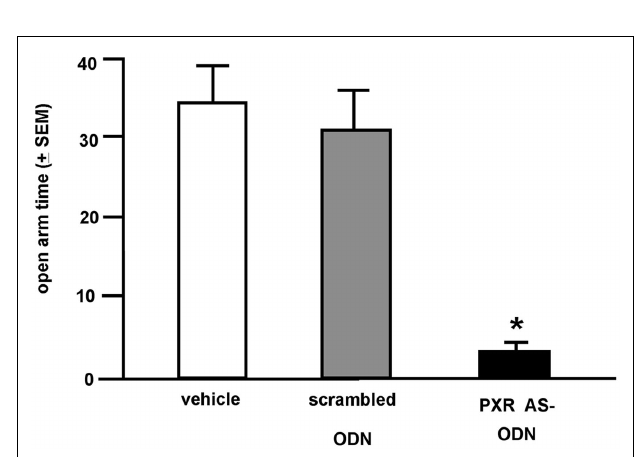
FIGURE 5 | Dot blots demonstrating the presence of pregnane xenobiotic receptor (PXR), steroidogenic acute regulatory protein (StAR), P450 side chain cleavage enzymes (P450scc), 5 α -reductase, and 3 α -hydroxysteroid dehydrogenase (3 α -HSD) in the rat midbrainVTA. NP indicates n o p rotein.